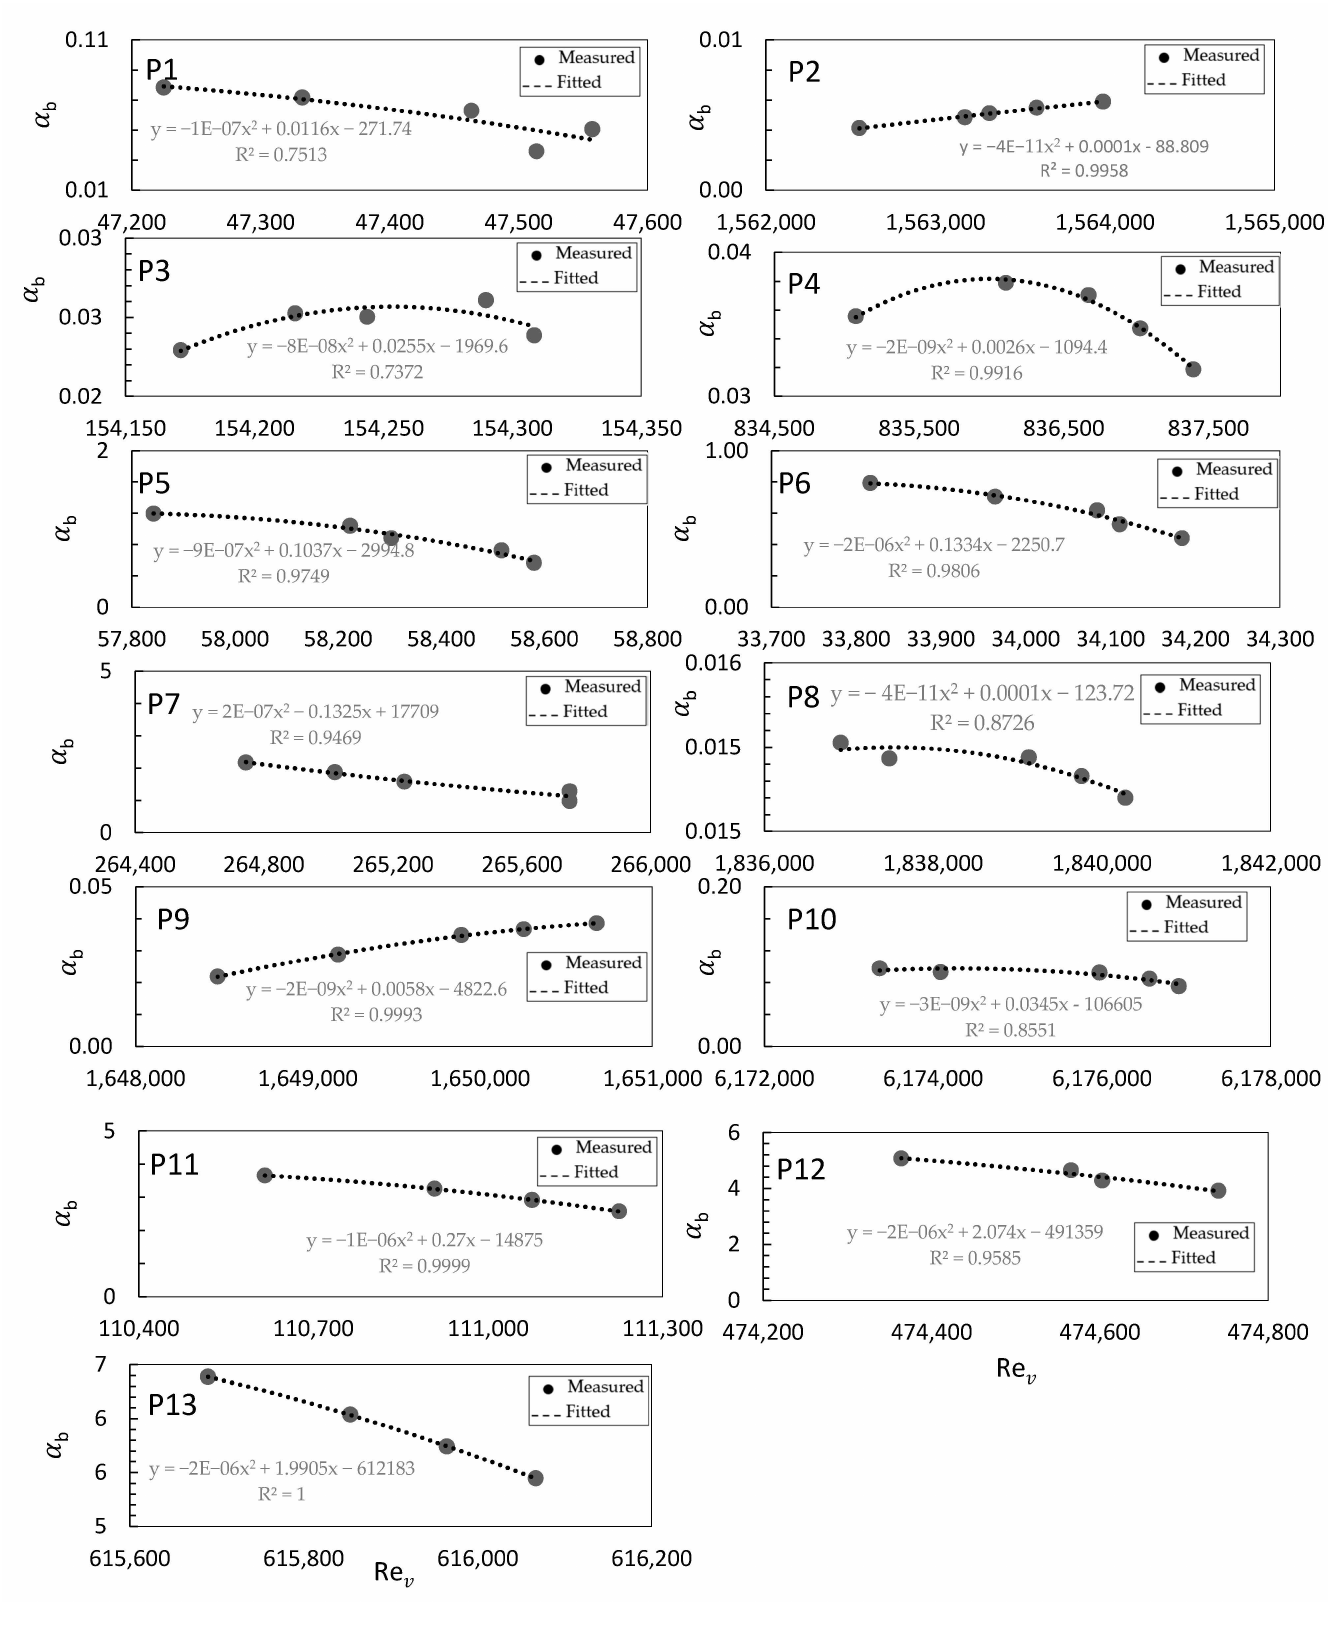
Figure 10. Variations in the drag coefficient factor α b with Re v